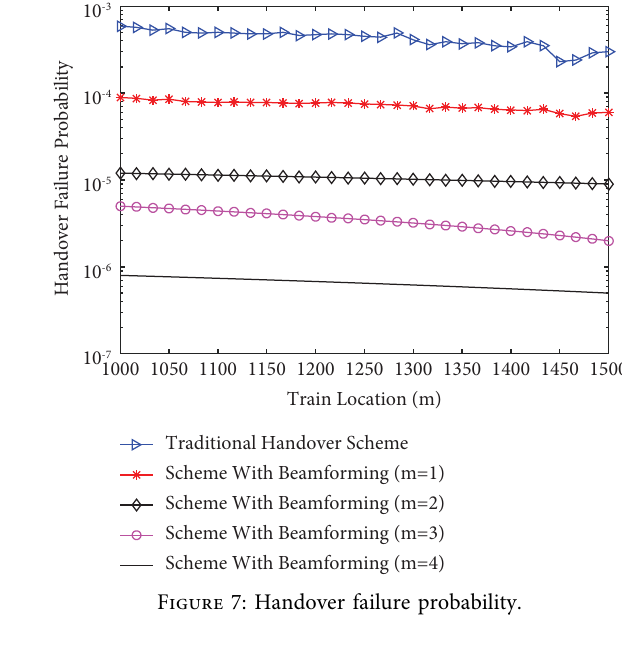
Figure 7: Handover failure probability.